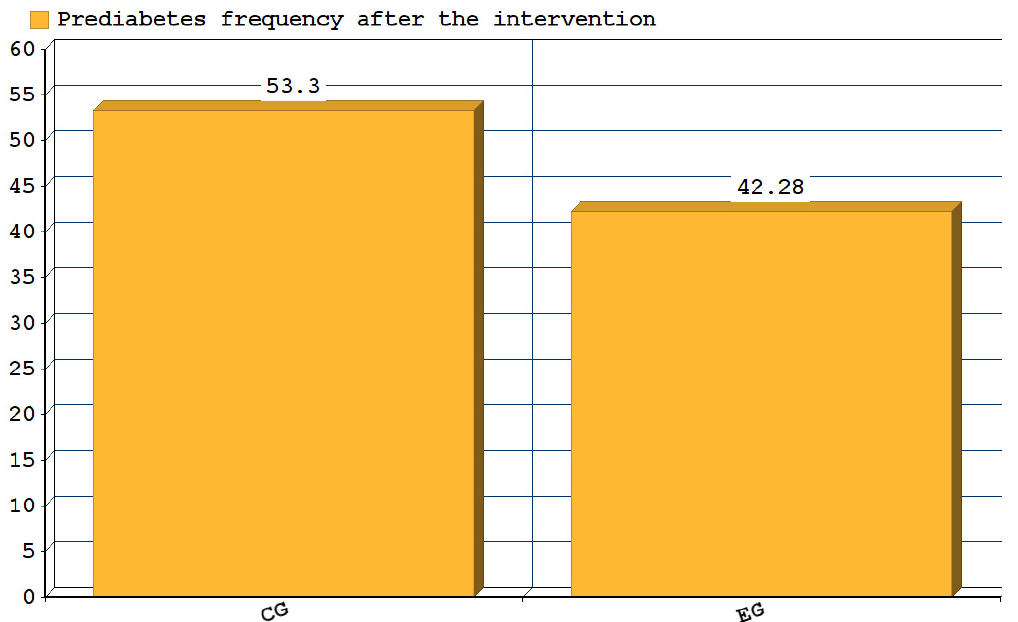
Figure 4. Prediabetes frequency after the intervention (V4) in the control and experimental group.